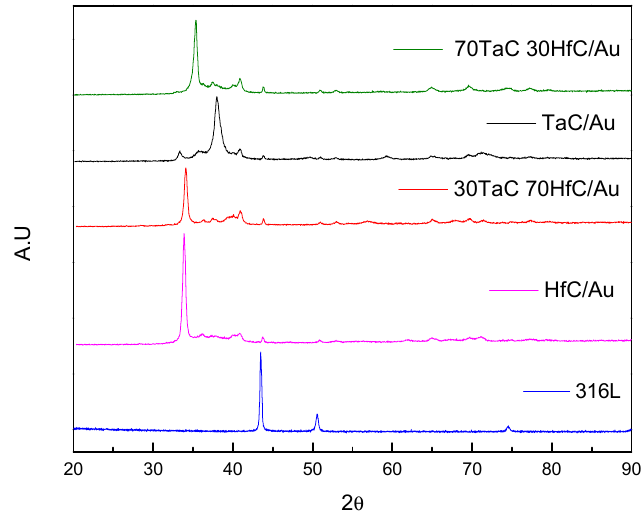
Figure 2. Diffraction pattern of the substrate and the different samples of TaC/Au, HfC/Au, 30TaC/Au, and 70TaC-30HfC/Au studied using XRD.